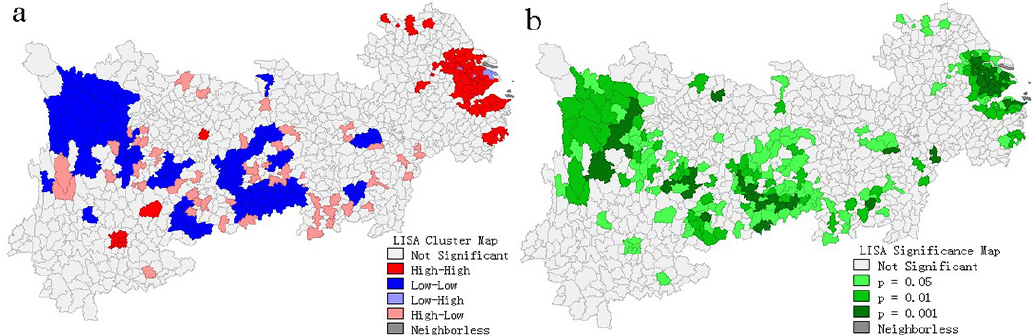
Figure 9. Urban space agglomeration map and saliency map of the YREB in 1999. ( a ) LISA cluster map of the YREB in 1999, ( b ) LISA significance map of the YREB in 1999.